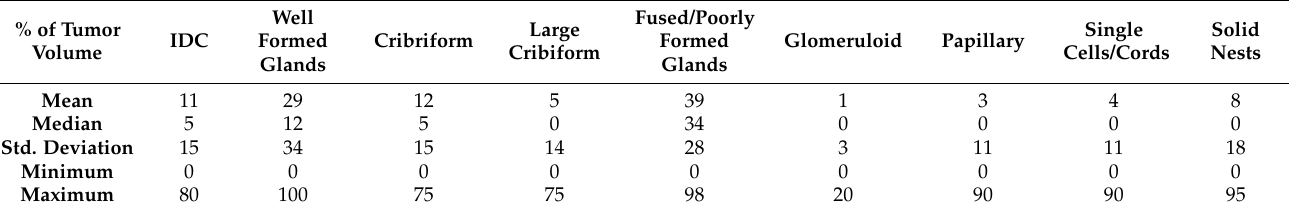
Table 2. Distribution of the different